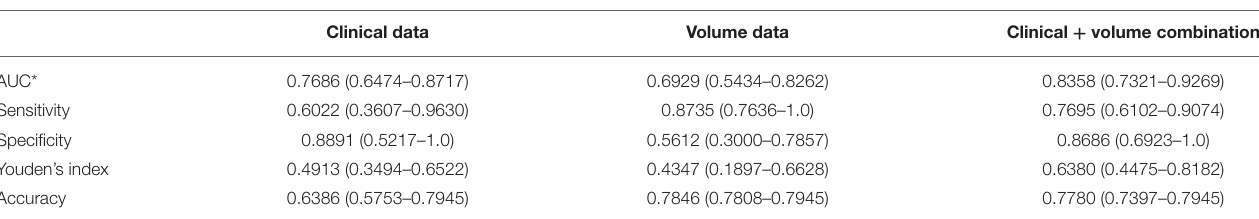
TABLE 2 | Comparison between different feature sets.